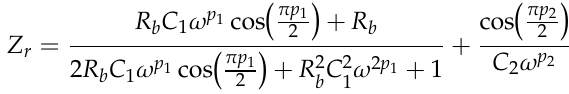
Figure 2. Schematic illustration of the fabricated EDLC for characterization.